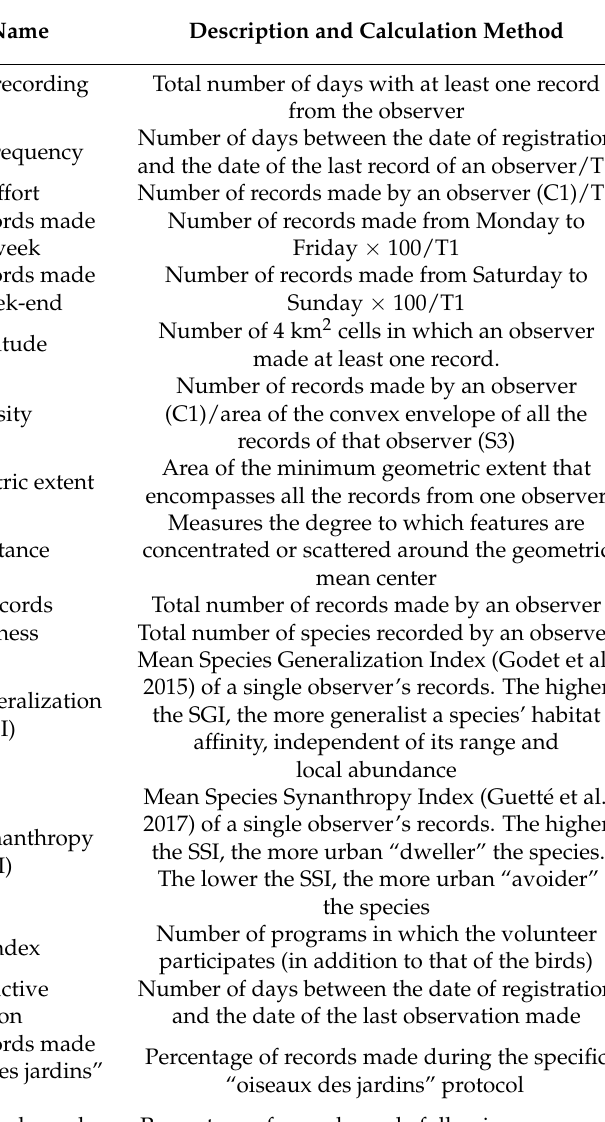
Table A1. The 22 metrics calculated to analyze observer profiles, in three categories (temporal habits (T), spatial habits (S), and record quality (C)), with their description and methods used for their